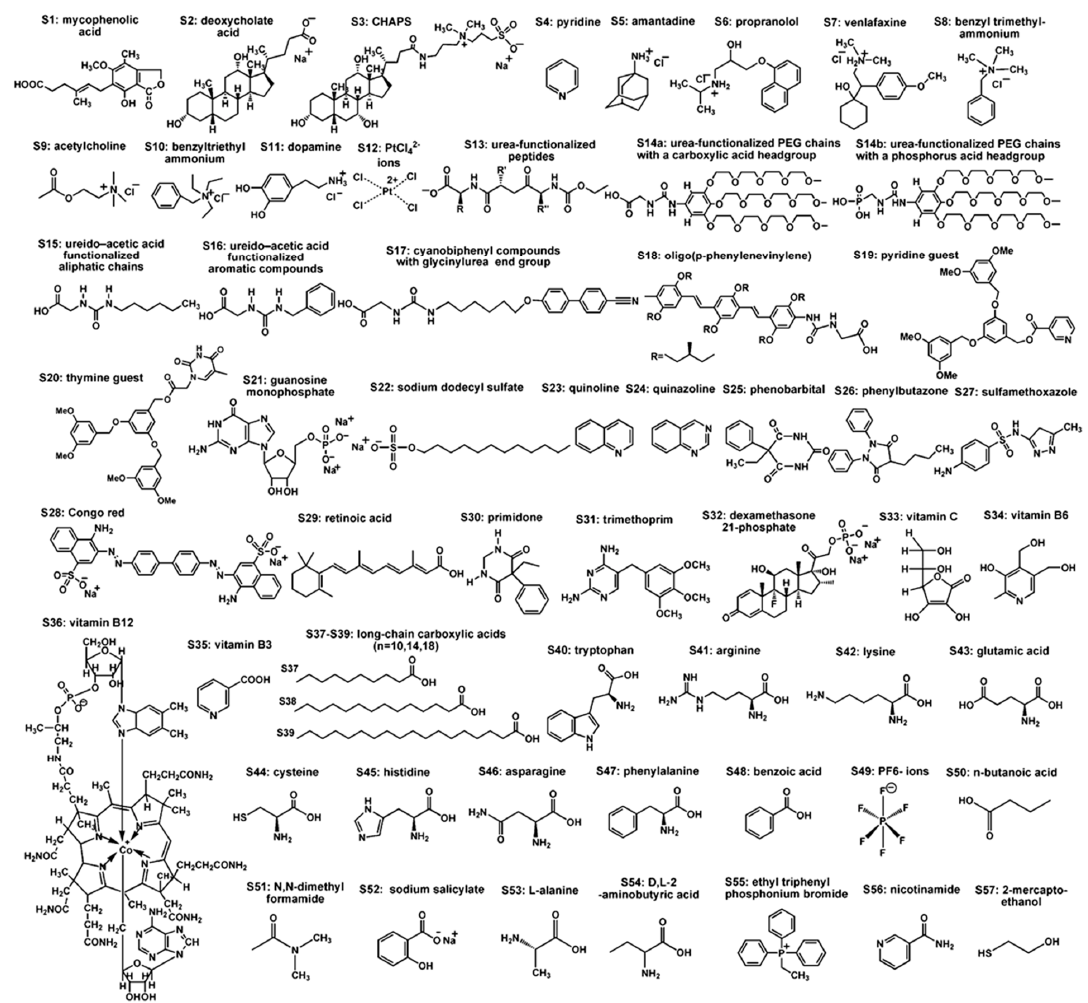
Figure 34. Various guest molecule structures examined using NMR methodologies as described by Cheng et al. Reprinted with permissions from [97]. Copyright 2012 American Chemical Society.